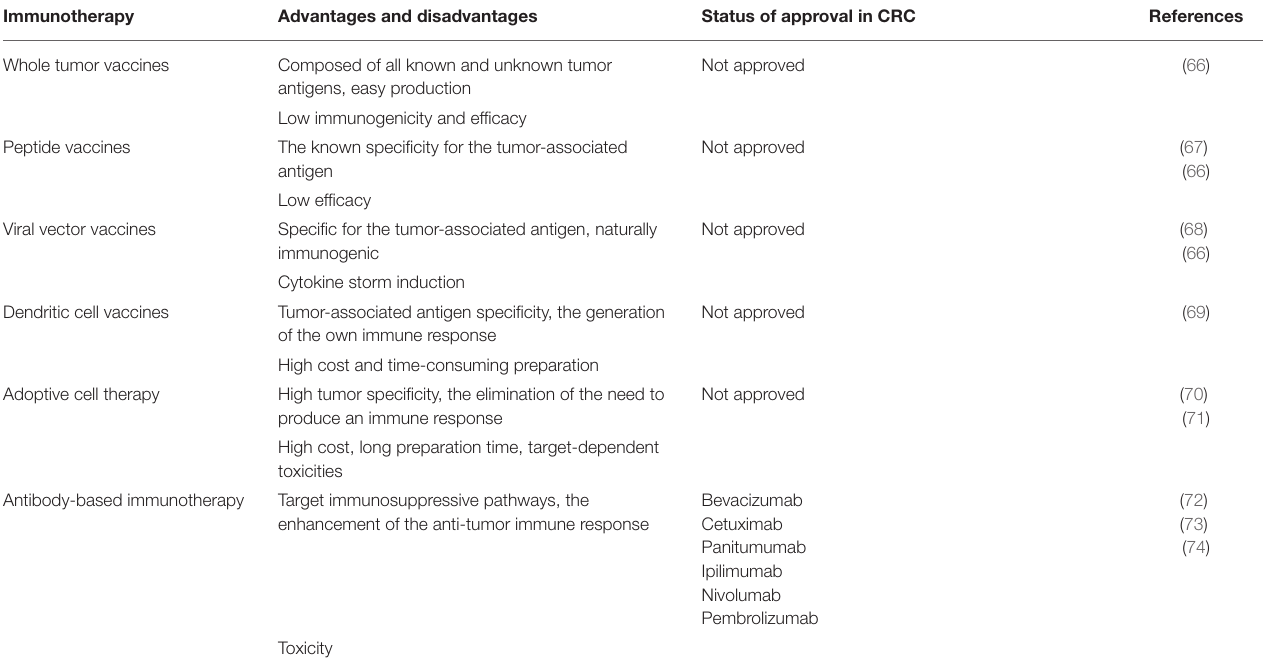
TABLE 3 | Advantages and disadvantages of immunotherapeutic